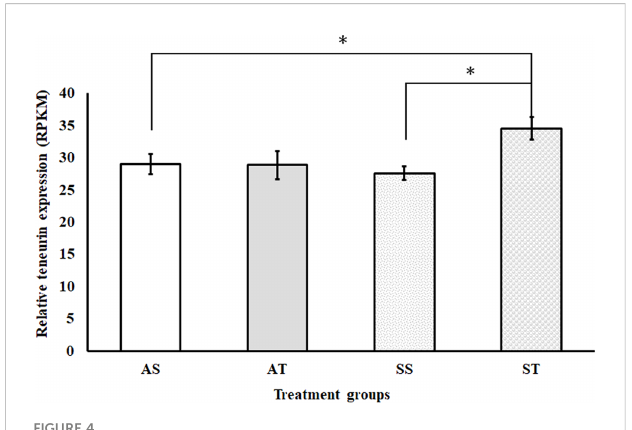
FIGURE 4 Relative expression (RPKM) of the teneurin gene in the heart of SRO under ambient or stress conditions and IM-injected with 5 pmol sroTCAP or FSSW (n=3). AS- oysters at ambient condition injected with FSSW, AT- oysters at ambient condition injected with sroTCAP, SS- oysters under stress condition injected with FSSW and ST- oysters under stress condition injected with sroTCAP. * P ≤